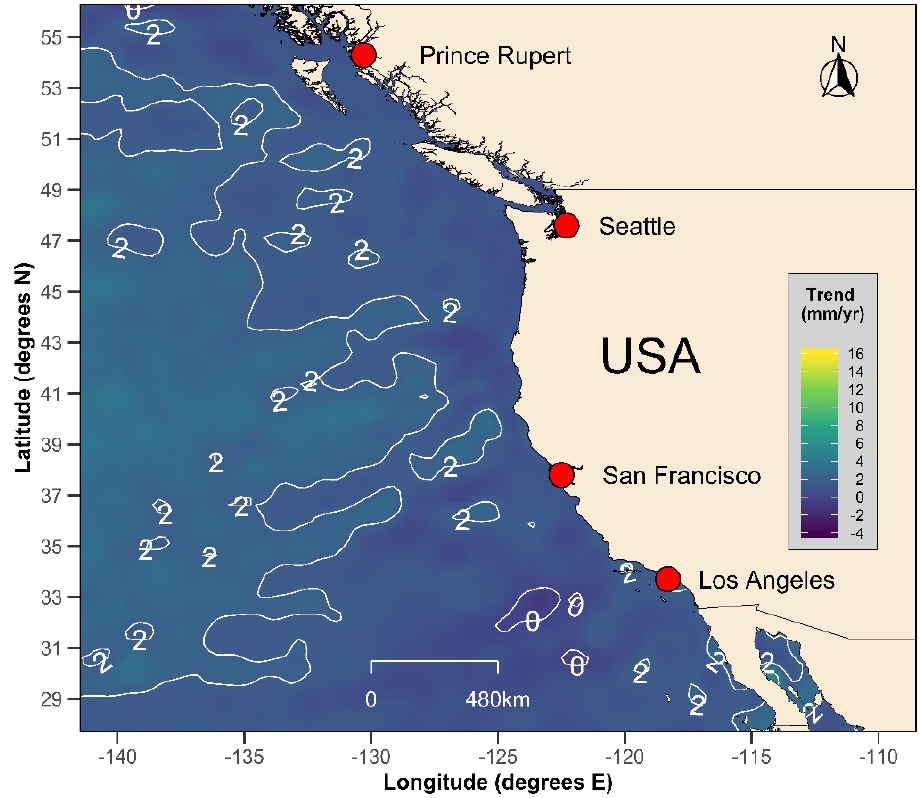
Figure 7. Panel 1—SSHA Trends (September 1992–October 2019) from AVISO data [30]. Trend contours are advised at 2 mm/year intervals. Refer also to Figure 6.